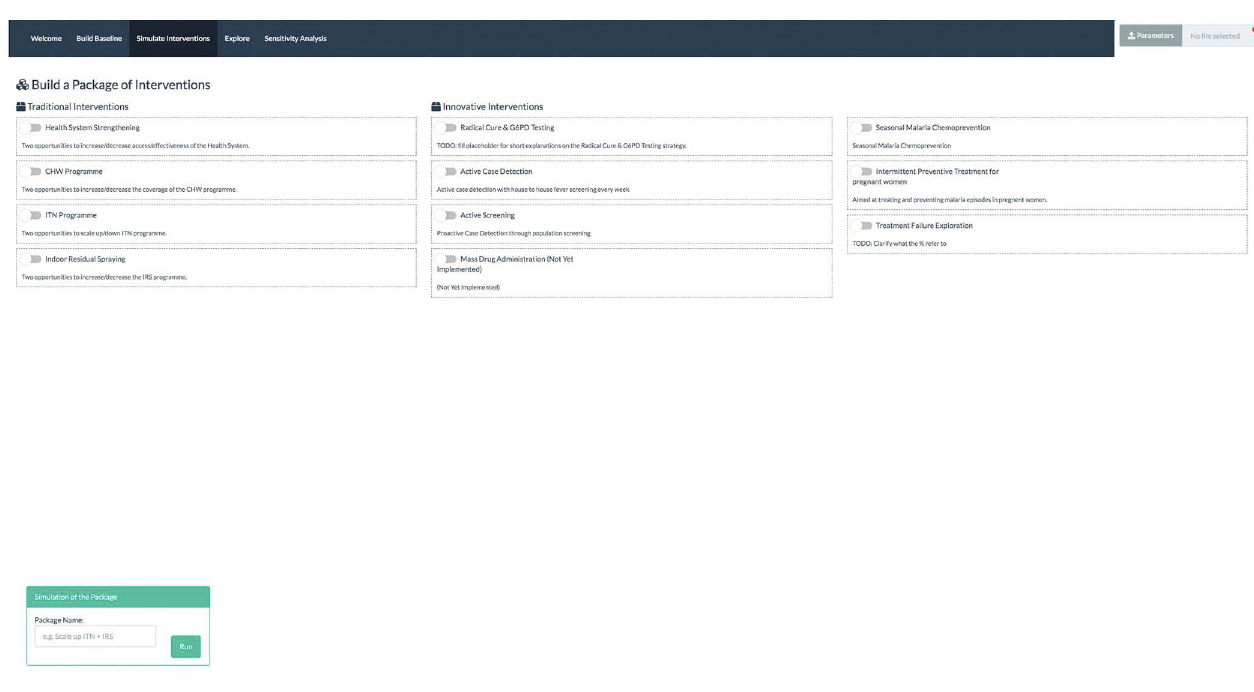
Fig 2. Interface for setting values of each intervention scenario to be